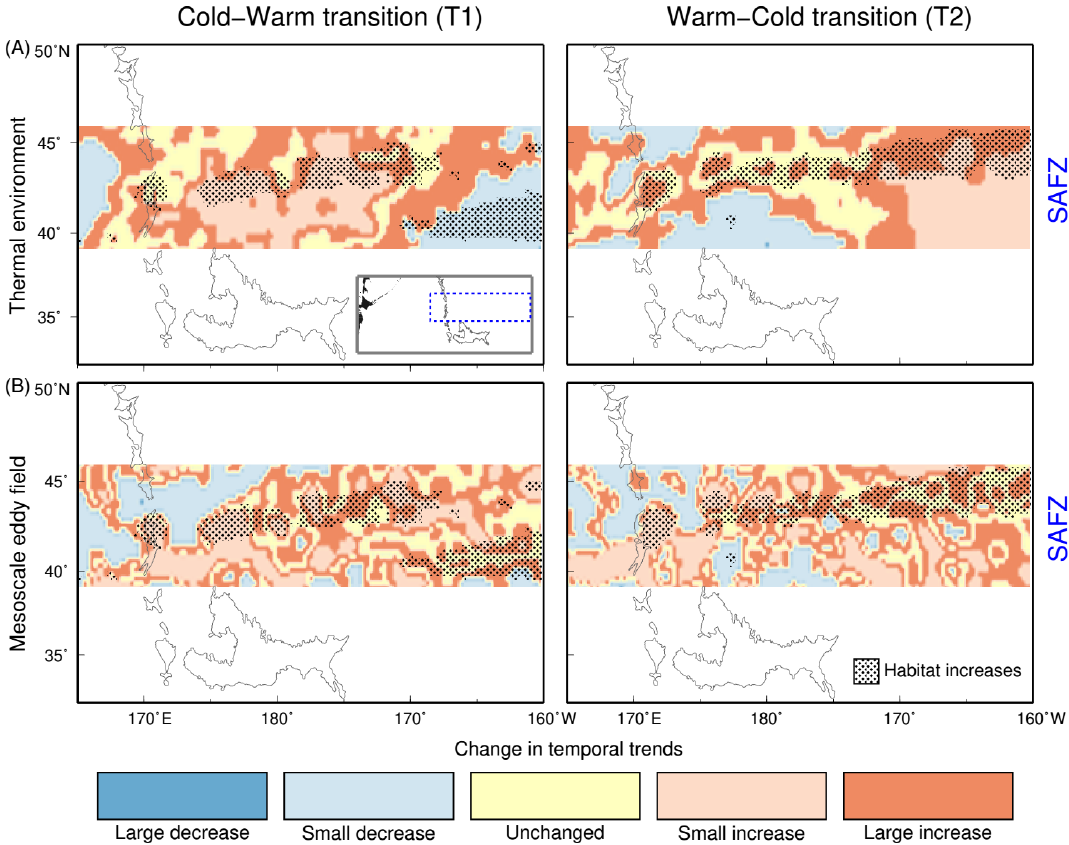
Figure 7. Maps showing the spatial overlap in regions of small and large increases in potential squid habitat (overlain dot-filled polygons) with the categorized temporal trend changes in the ( A ) thermal environment and ( B ) mesoscale eddy field, during the cold-warm (T1, left panels) and warm-cold (T2, right panels) PDO phase transitions. The subset area (subarctic frontal zone, SAFZ) corresponds to the dashed bordered polygon in the inset map. Seafloor features are also highlighted in solid gray lined polygons.